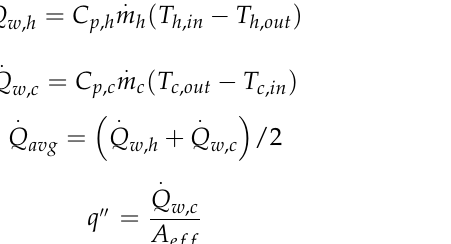
Table 2. Test conditions.